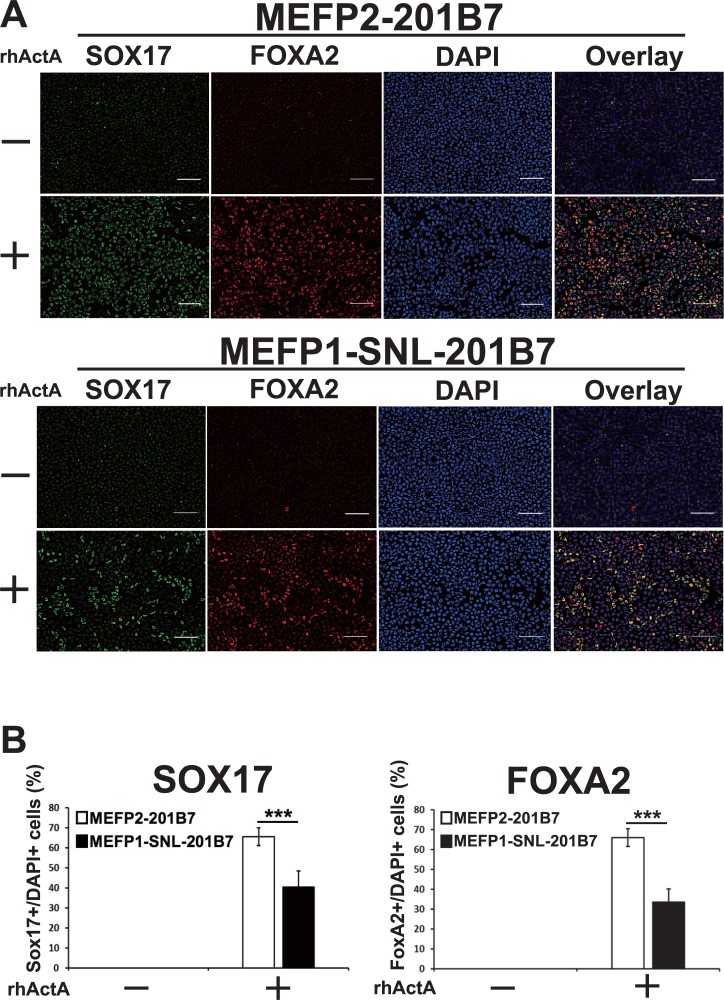
Immunofluorescent staining of SOX17 and FOXA2 proteins in DE differentiated MEFP2- and MEFP1-SNL-201B7 cells.The images of SOX17 (green) and FOXA2 (red), and DAPI (blue) are shown (A). White scale bars, 100 μm. The percentages of SOX17 (B, left panel) and FOXA2 (B, right panel)-positive cells per DAPI-positive cells (n = 8 each) were calculated based on DE marker-positive and DAPI-positive cell numbers. Data represent the mean ± SEM and are representative of three experiments. ***p < 0.001 versus MEFP2-201B7 cells.